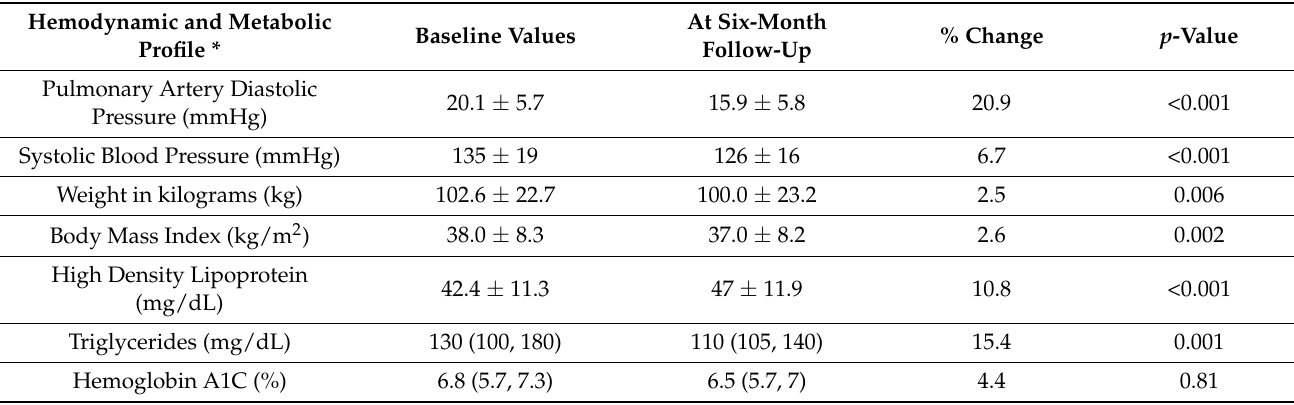
Table 2. Changes in hemodynamics and metabolic traits. Paired t -tests or Wilcoxon’s signed-rank tests were used to assess changes from